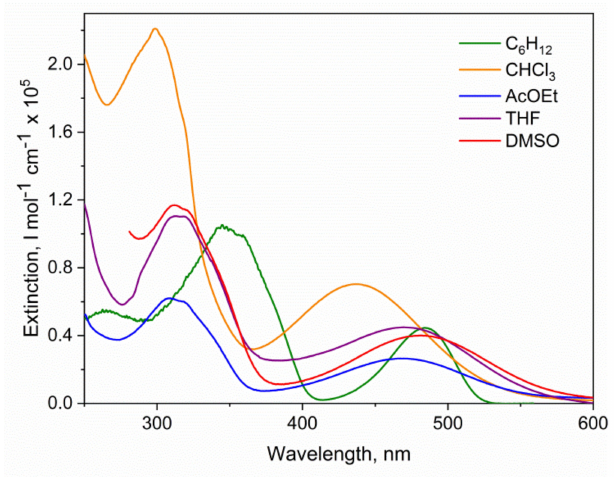
Figure 2. UV–Vis spectra for solutions of compound 1b